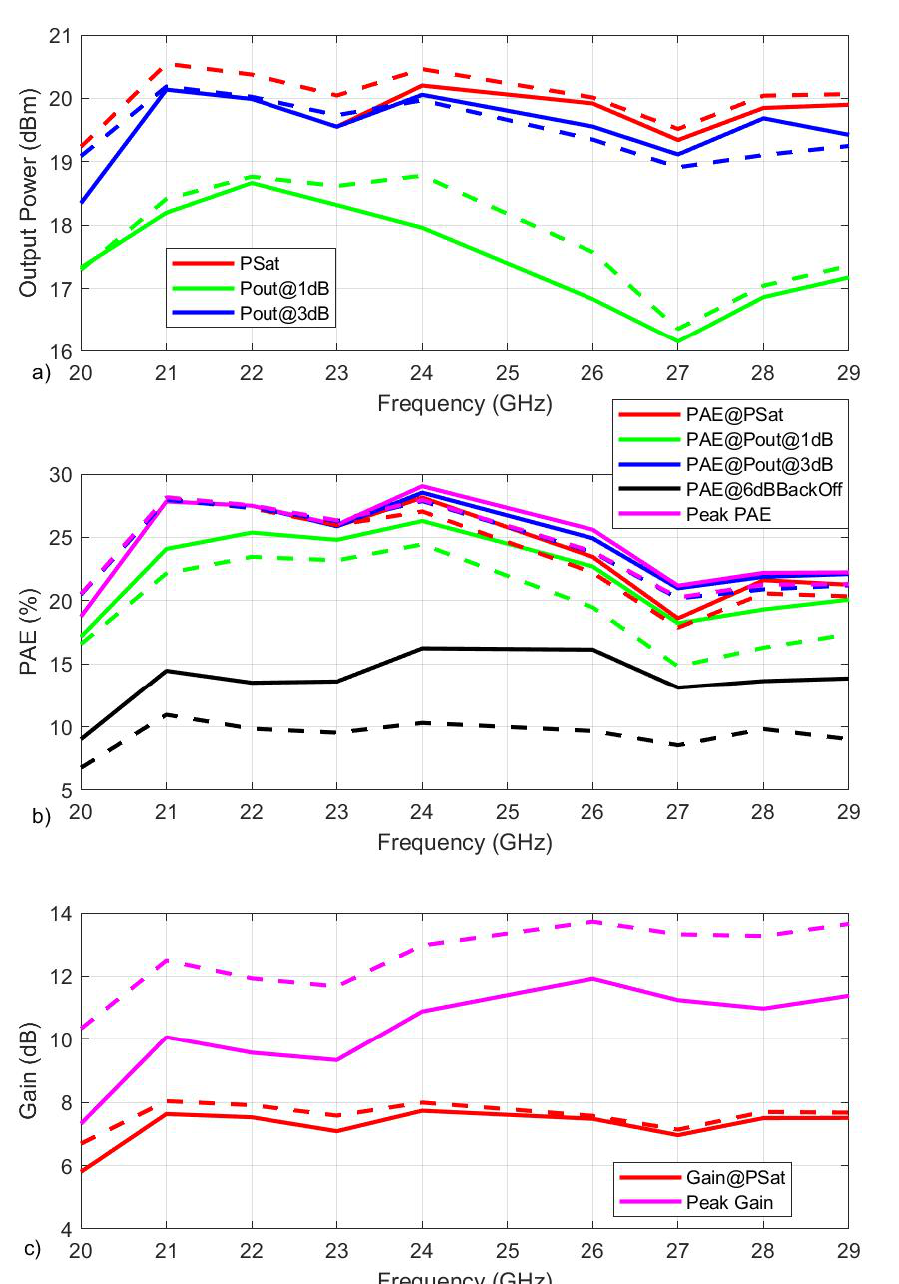
Figure 9. Measured figure of merits vs. frequency. ( a ) Pout, ( b ) PAE and ( c ) gain with I dQ = 17.7mA (solid line) and I dQ = 48.7mA (dashed